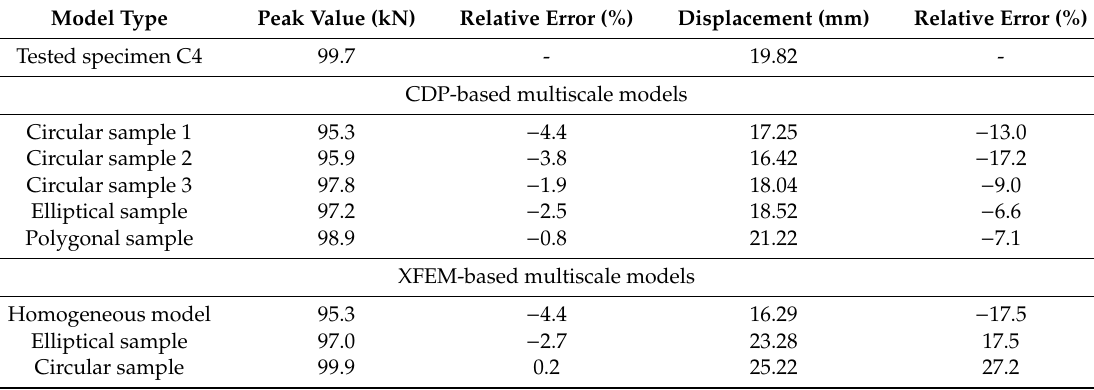
Figure 17. Load-displacement curves calculated with multiscale models. Table 5. Comparison of peak load values and corresponding displacement.